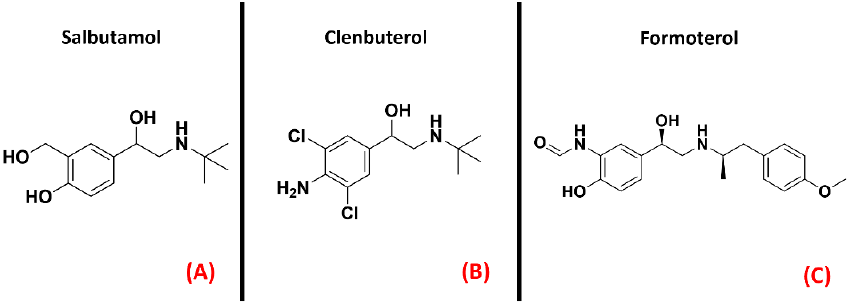
Figure 16. The chemical structures of the adrenergic β 2 receptor agonists Salbutamol ( A ), Clenbuterol ( B ), and Formoterol ( C ).